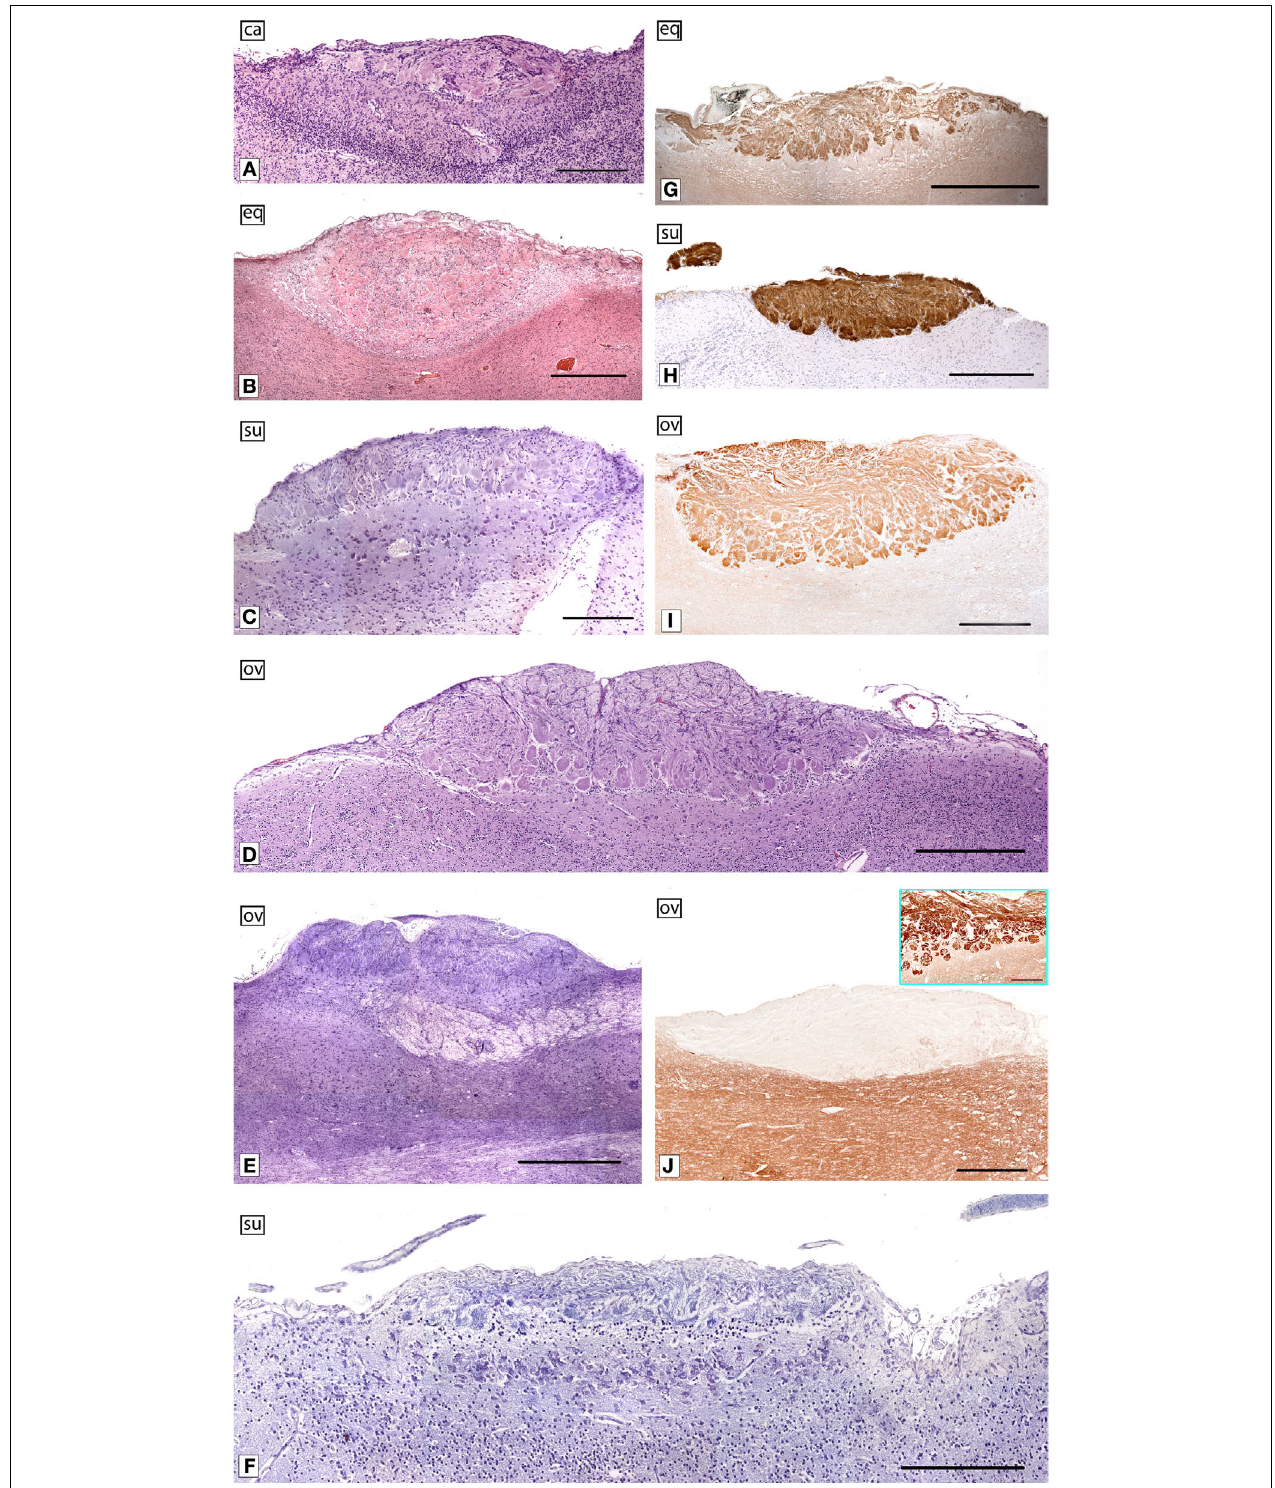
UEA-I (H) , and immunolabeled by G (I) and G (J) . The inset in (J) shows the i2 α o labeling in the main bulb. LEA, Lycopersicum esculentum agglutinin; UEA-I Ulex europaeus agglutinin I. (Salazar and Sánchez-Quinteiro, 2003; Salazar et al.,2000, 2006). Scale bars = 250 µm (A,C,F) , 1 mm (B,E,G) , 500 µm (D,H–J)